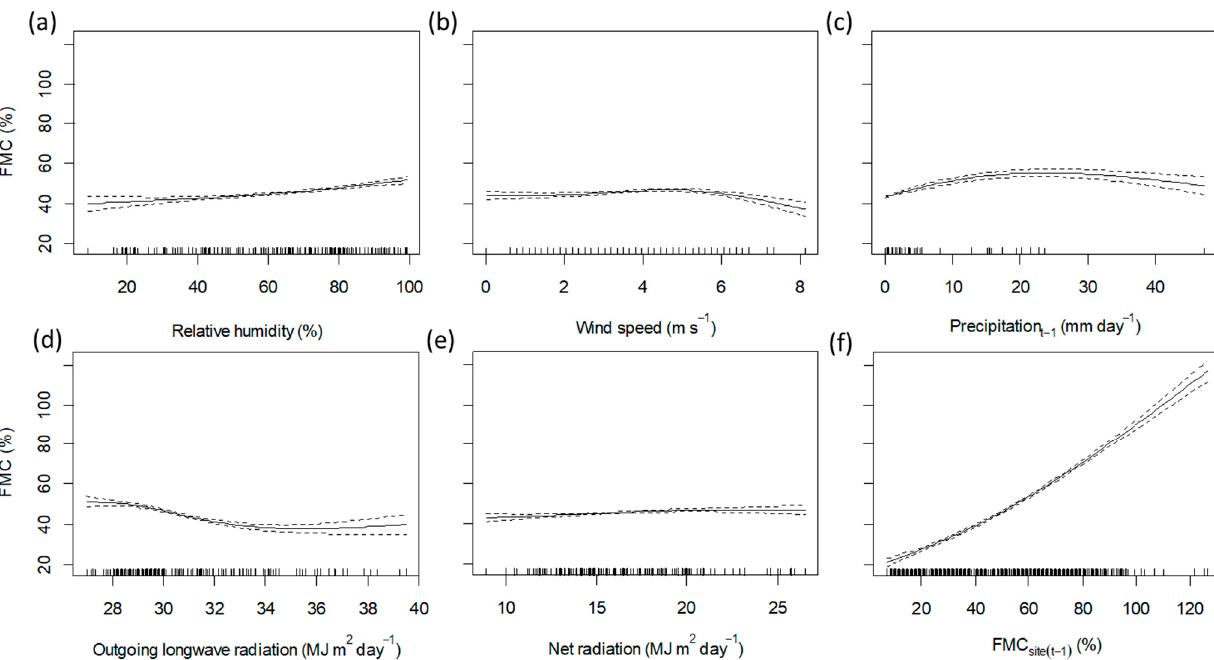
Figure 7. Partial plots of GAMM AR fits for mean daily FMC, ( a ) relative humidity, ( b ) maximum wind speed, ( c ) precipitation t − 1 , ( d ) outgoing longwave radiation, ( e ) net radiation and (f) FMC site(t − 1) . Plots are centered on mean FMC with 95% confidence intervals.